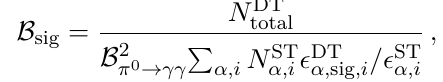
Figure 5 . Fit to the M sig distribution of the DT candidates from the data samples at 4 . 226 GeV. The data are represented by points with error bars, the total fit by the blue solid line, and the fitted signal and the fitted background by the red dotted and the black dashed lines,